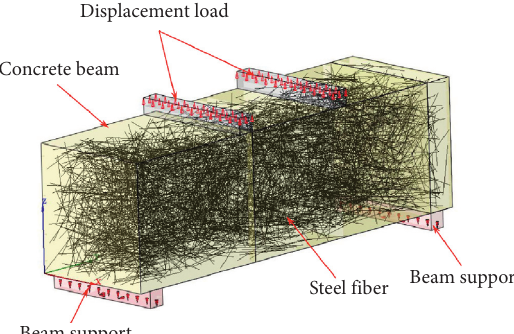
Figure 3: Three-dimensional meso-scale numerical model of an SFRC beam.